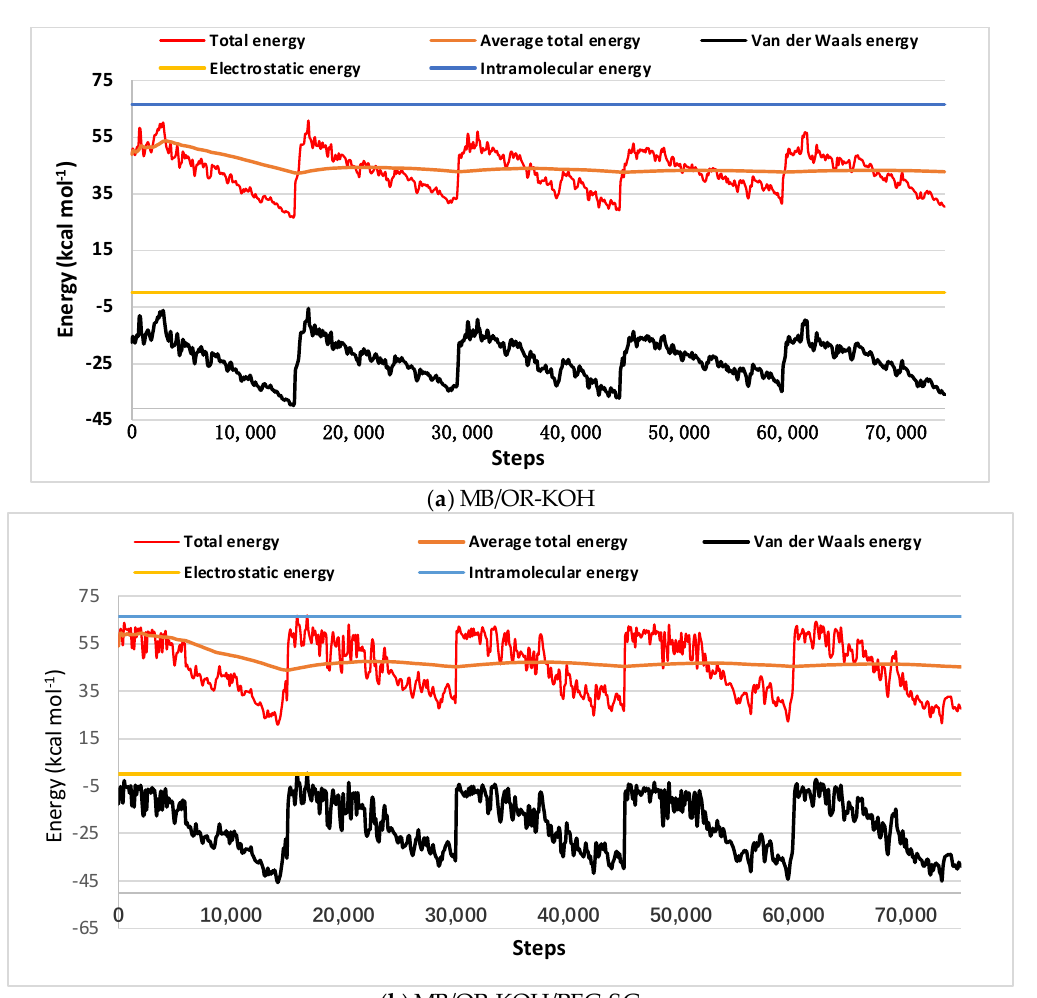
Figure 7. Fluctuating curves of the interaction energies of MB in aqueous solution on different adsorbents: ( a ) OR-KOH and ( b ) OR-KOH/PEG-SG.